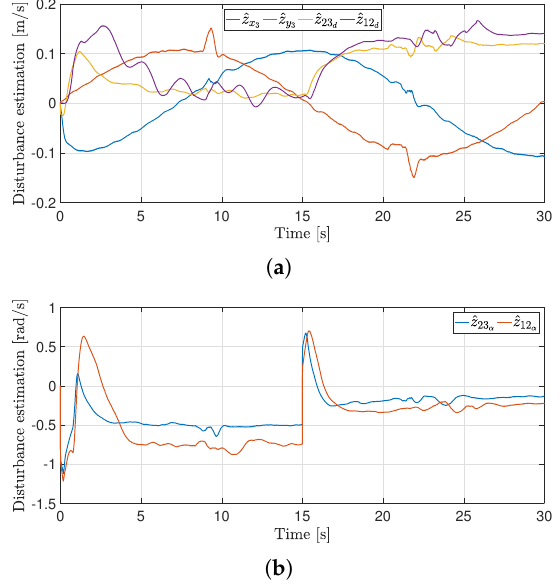
Figure 16. On line total disturbance estimation. ( a ) Total disturbance estimation of the longitudinal velocity. ( b ) Total disturbance estimation of angular